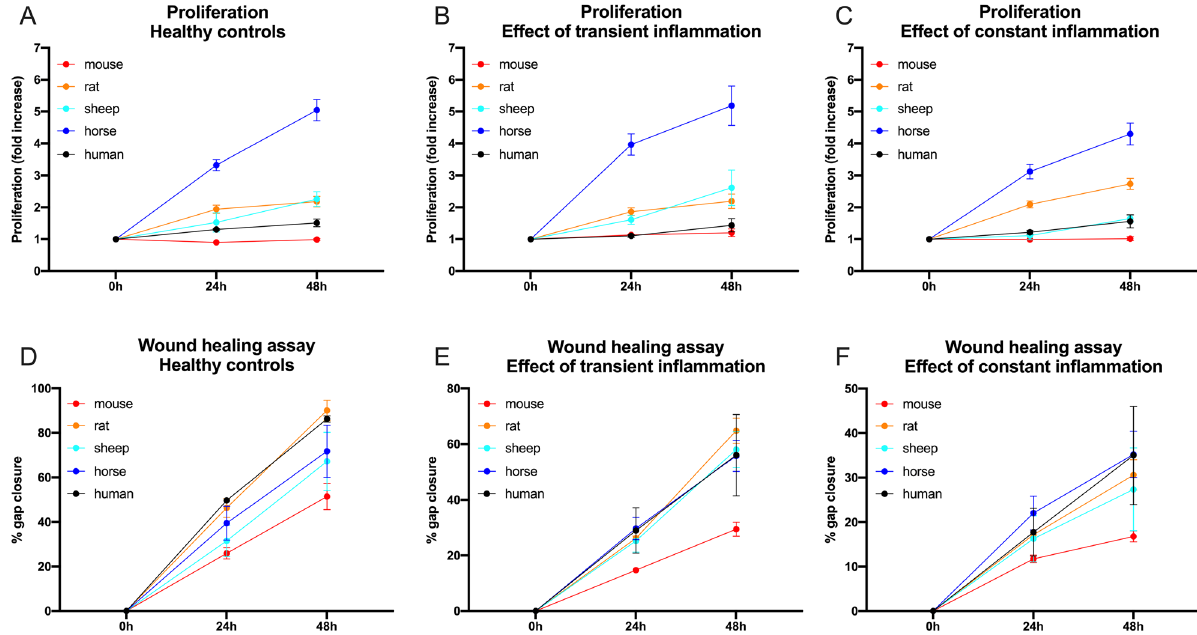
Figure 3. The proliferation capacity ( A – C ) of tenocytes from 5 different mammalian species (mouse, rat, sheep, horse, and human) under healthy (Ctr/A), transient (TI/B) and constant (CI/C) inflammatory condition is illustrated as fold increase over the course of 2 days (indicated as mean ± SEM calculated from three biological replicates). For pairwise comparisons and significance values see Table 1. A wound healing assay ( D - F ) was used to determine the migratory capacity of tenocytes from five different mammalian species under healthy ( D ), transient ( E ) and constant ( F ) inflammatory conditions (indicated as mean ± SEM calculated from three biological replicates). For pairwise comparisons and significance values see Table 1.